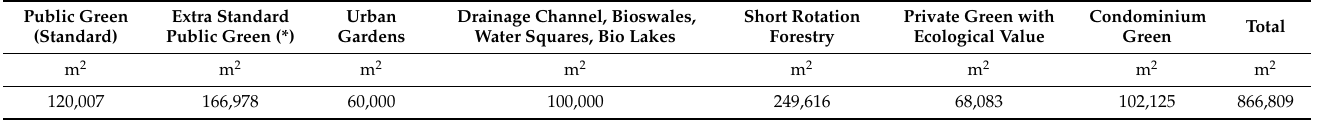
Table 7. Soil (inside the CUM) used for environmentally compatible